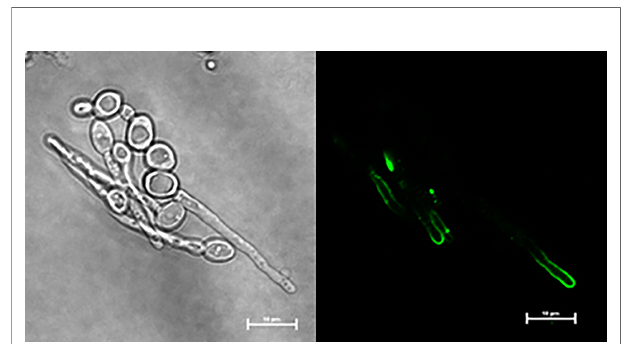
FIGURE 5 | Anti-Hwp1 immunolabeling of C. dubliniensis cells. Strain CD36 was grown for 2 h in 10% FBS diluted with MilliQ water, then immunolabeled with anti-Hwp1 MAb 2-E8 and a FITC-conjugated anti-mouse secondary antibody. Signal was observed toward the tip of some germ tubes. The scale bar in each image denotes 10